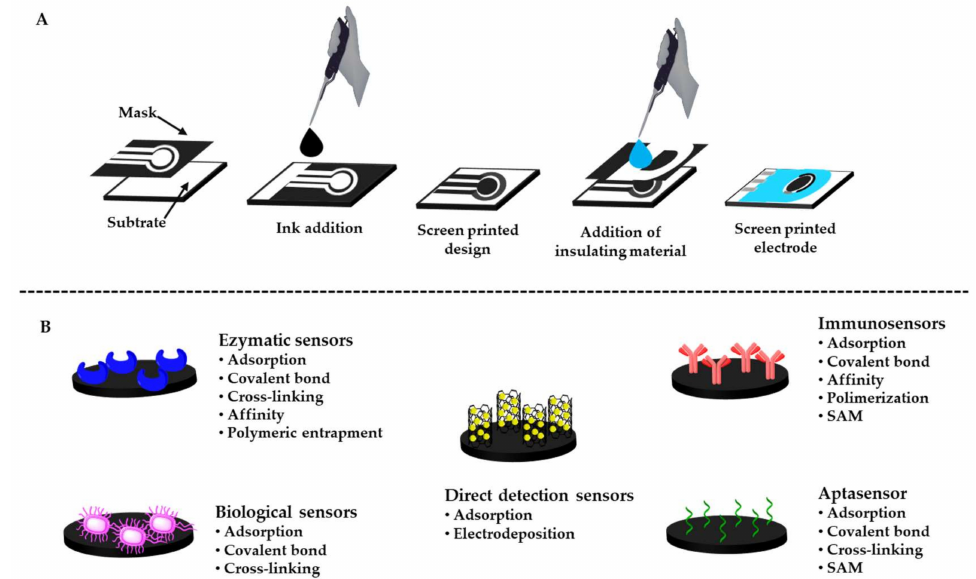
Figure 2. ( A ) Stages of the manufacturing process of screen-printed electrodes (SPEs). ( B ) Main methods used for the immobilization of (bio)receptors on the working electrode of SPEs for pesticides detection (SAM: Self Assembled